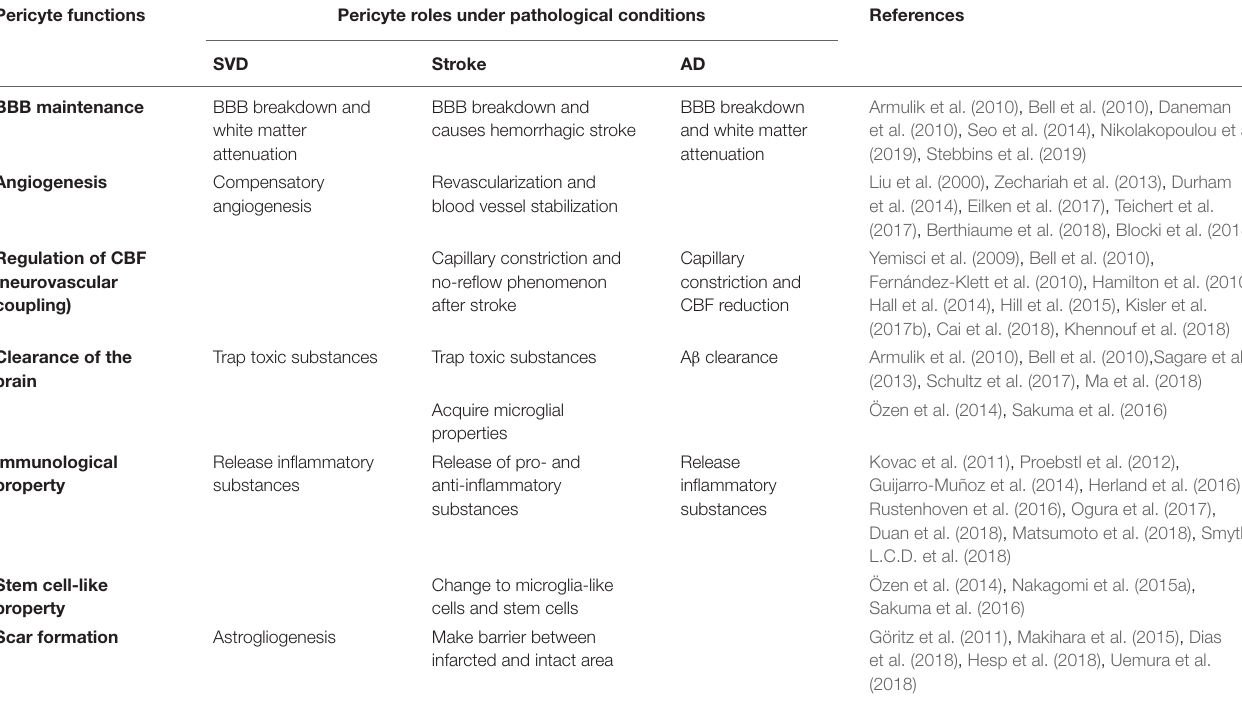
TABLE 2 | The roles of CNS pericytes in health and disease. Pericyte